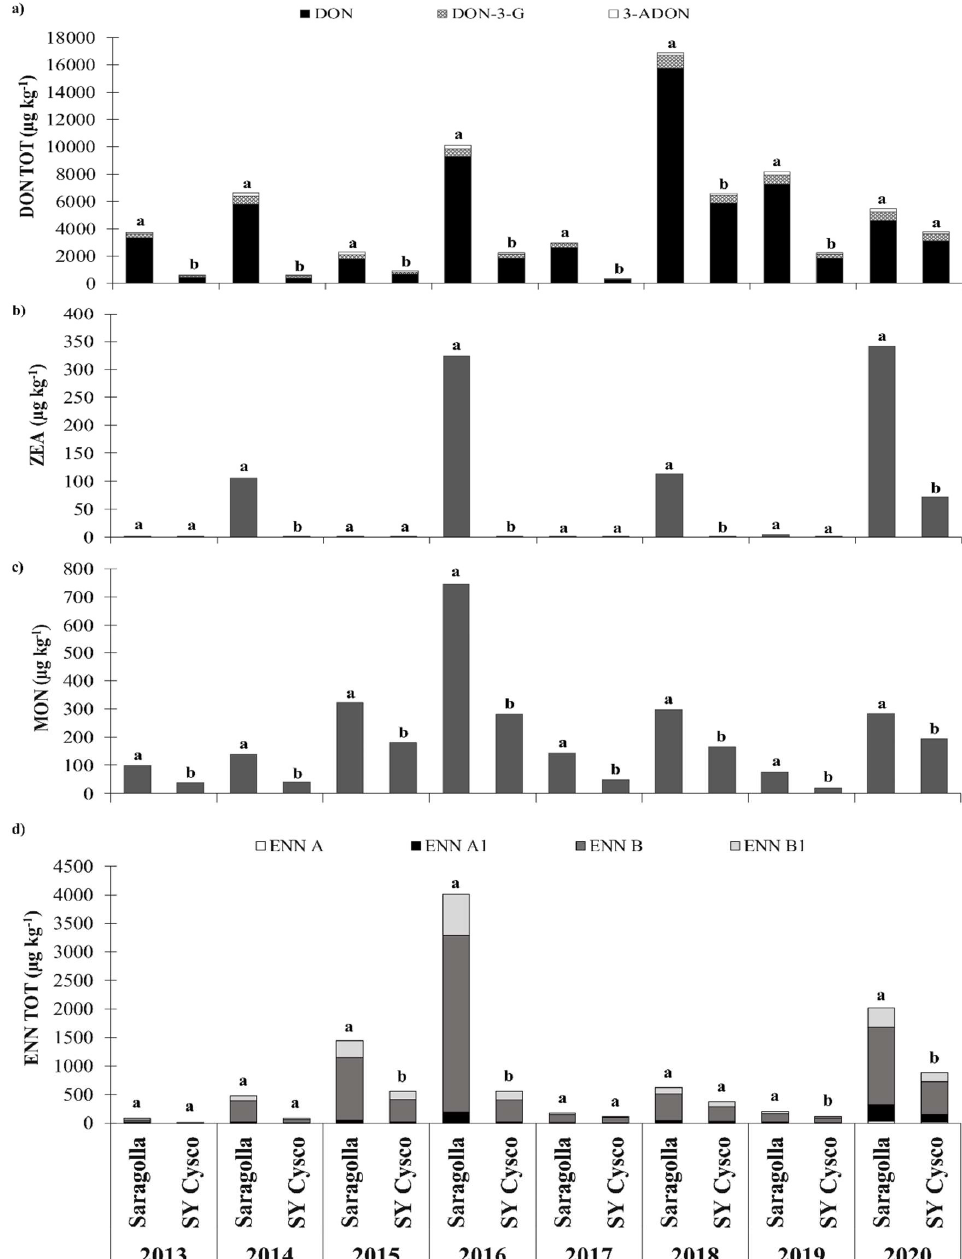
Figure 1. Effects of the growing season and durum wheat cultivar with different degrees of FHB susceptibility on the mycotoxin content in NW Italy during the 2012–2020 period: ( a ) Total deoxynivalenol content (DON TOT = sum of deoxynivalenol, DON; deoxynivalenol-3-glucoside, DON-3-G; and 3-acetyldeoxynivalenol, 3-ADON); ( b ) Zearalenone (ZEA) content; ( c ) Moniliformin (MON) content; ( d ) Total enniatin content (ENN TOT = sum of enniatin A, ENN A; enniatin A 1 , ENN A 1 ; enniatin B, ENN B; and enniatin B 1 , ENN B 1 ). Different letters above the bars indicate significant differences between cultivars for each growing season ( p < 0.05). The reported data are the average of 3 replications. Statistical analysis was performed on the transformed [ T; y’= ln (x + 1)] mycotoxin concentration values.